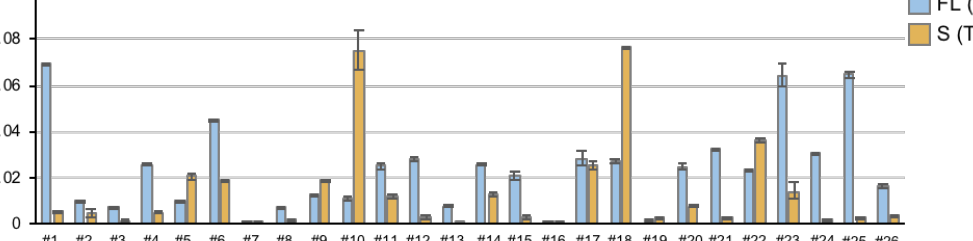
Figure 2. HIPK2-FL and HIPK2-S expression in normal and tumor tissues. ( a , b ) qPCR analysis of the expression levels of HIPK2-FL and HIPK2-S in different human, normal, tissue samples ( a ) and in a panel of human colon cancers and matched normal tissue ( b ). Values are shown as 2^-Ct multiplied by an arbitrary factor. ( c ) The expression levels of HIPK2-FL and -S were analyzed in different PDAC biopsies. GAPDH gene expression was used for data normalization. Data show a non-normal distribution by Shapiro‒Wilk normality test ( p < 0.01 for FL and p < 0.0001 for S).